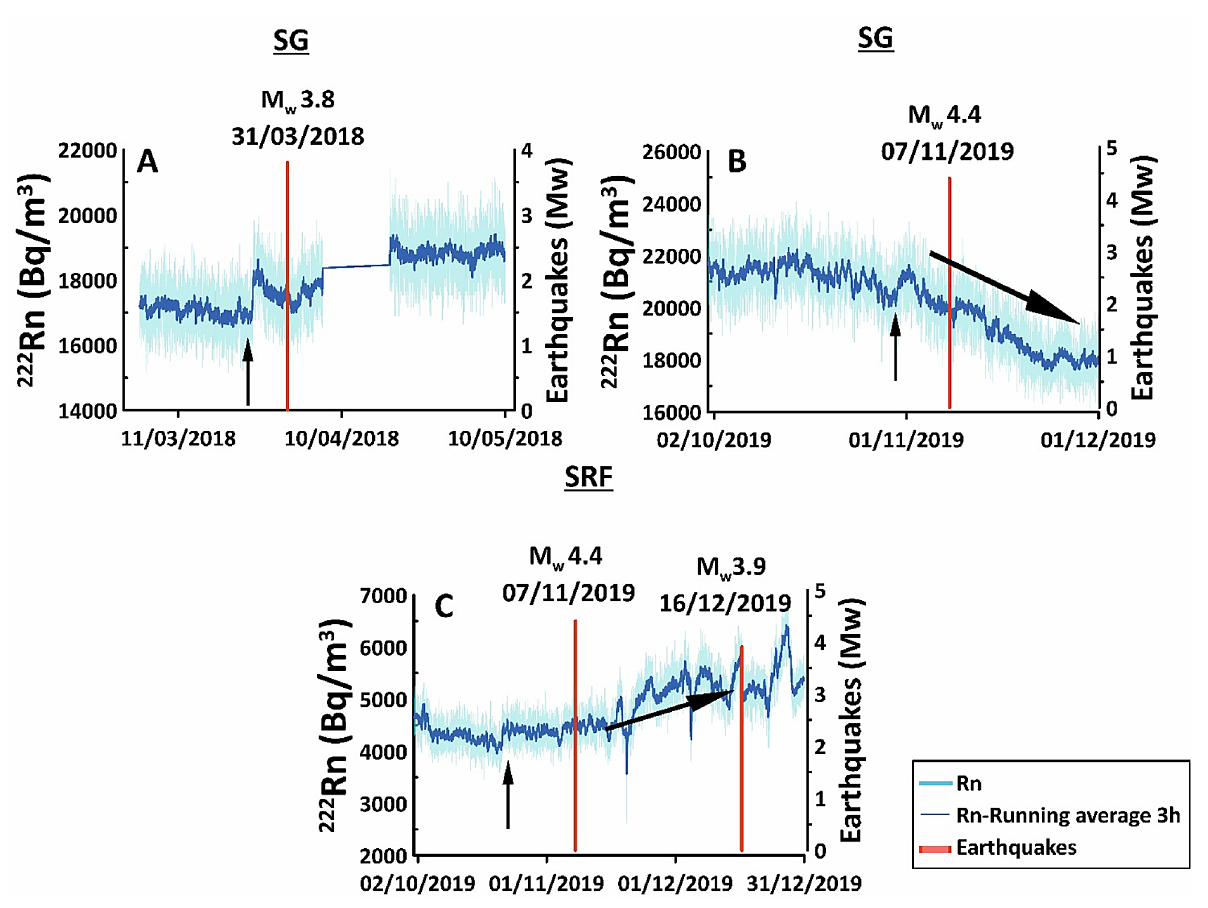
3.9 San Leucio del Sannio earthquake occurred on 16 December 2019 and M 3.8 L’Aquila earthquake w 4.4 Balsorano w w